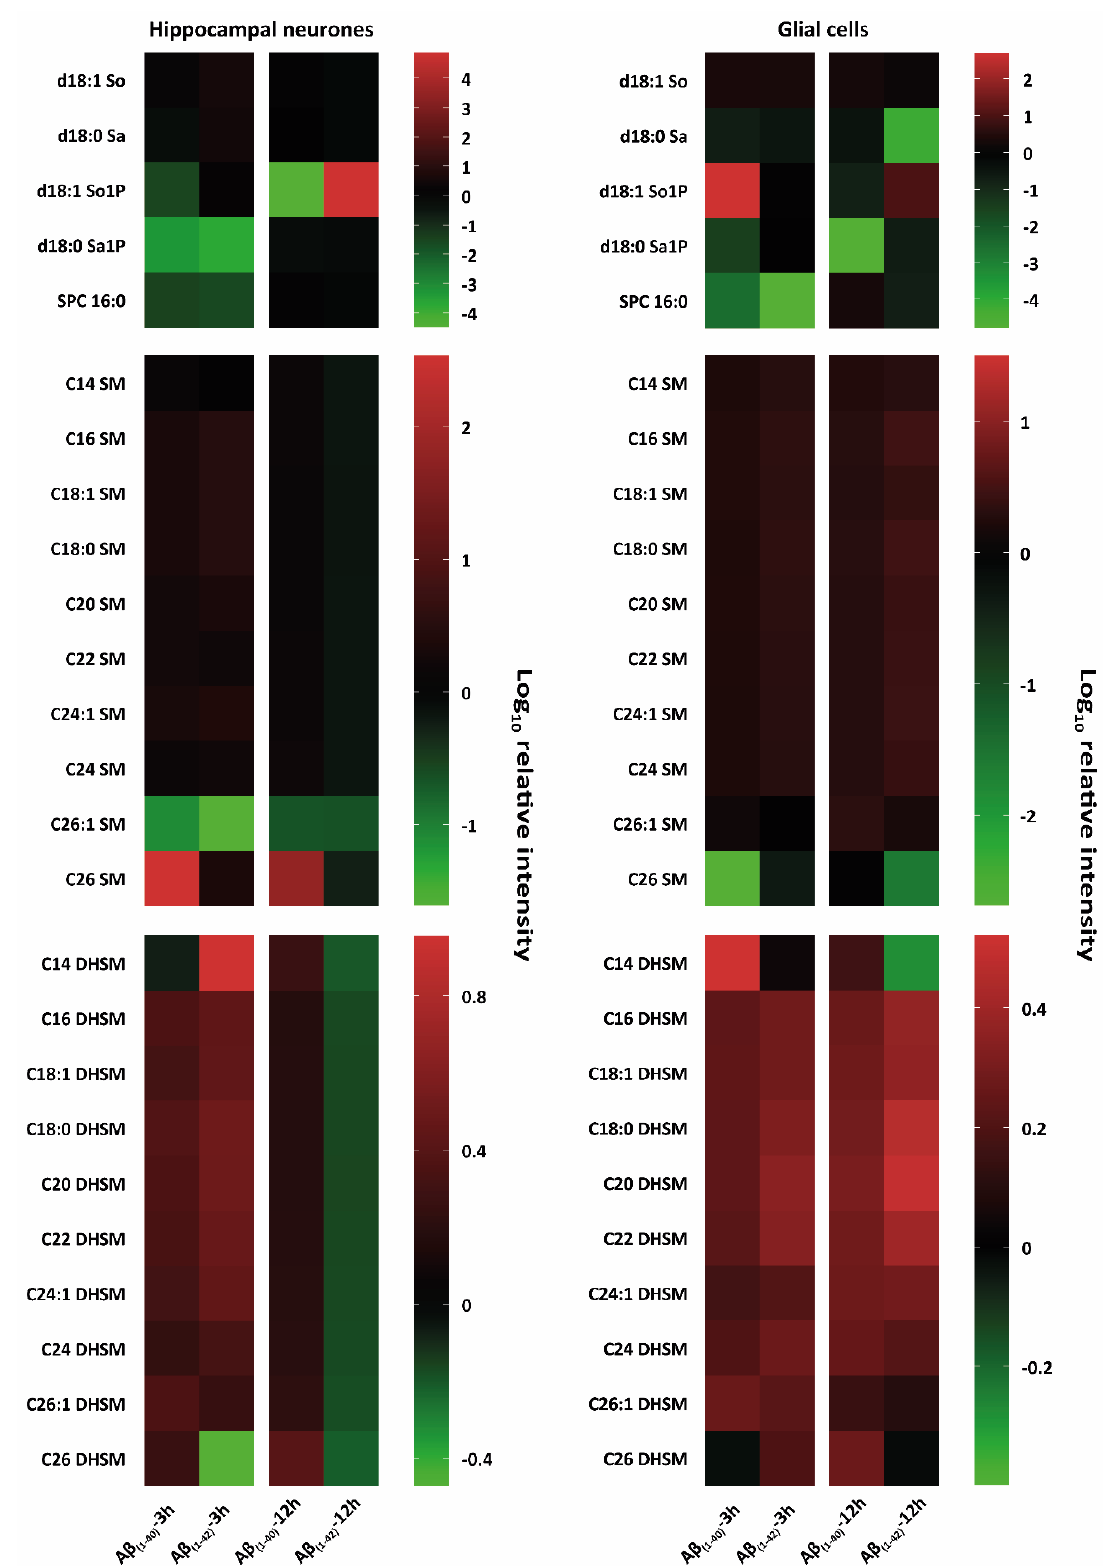
Figure 3. Heat-map-based mass spectrometry analysis of sphingophospholipid classes from hippocampal neurones and glial cells after 3 h and 12 h A β treatment. Here, we examined